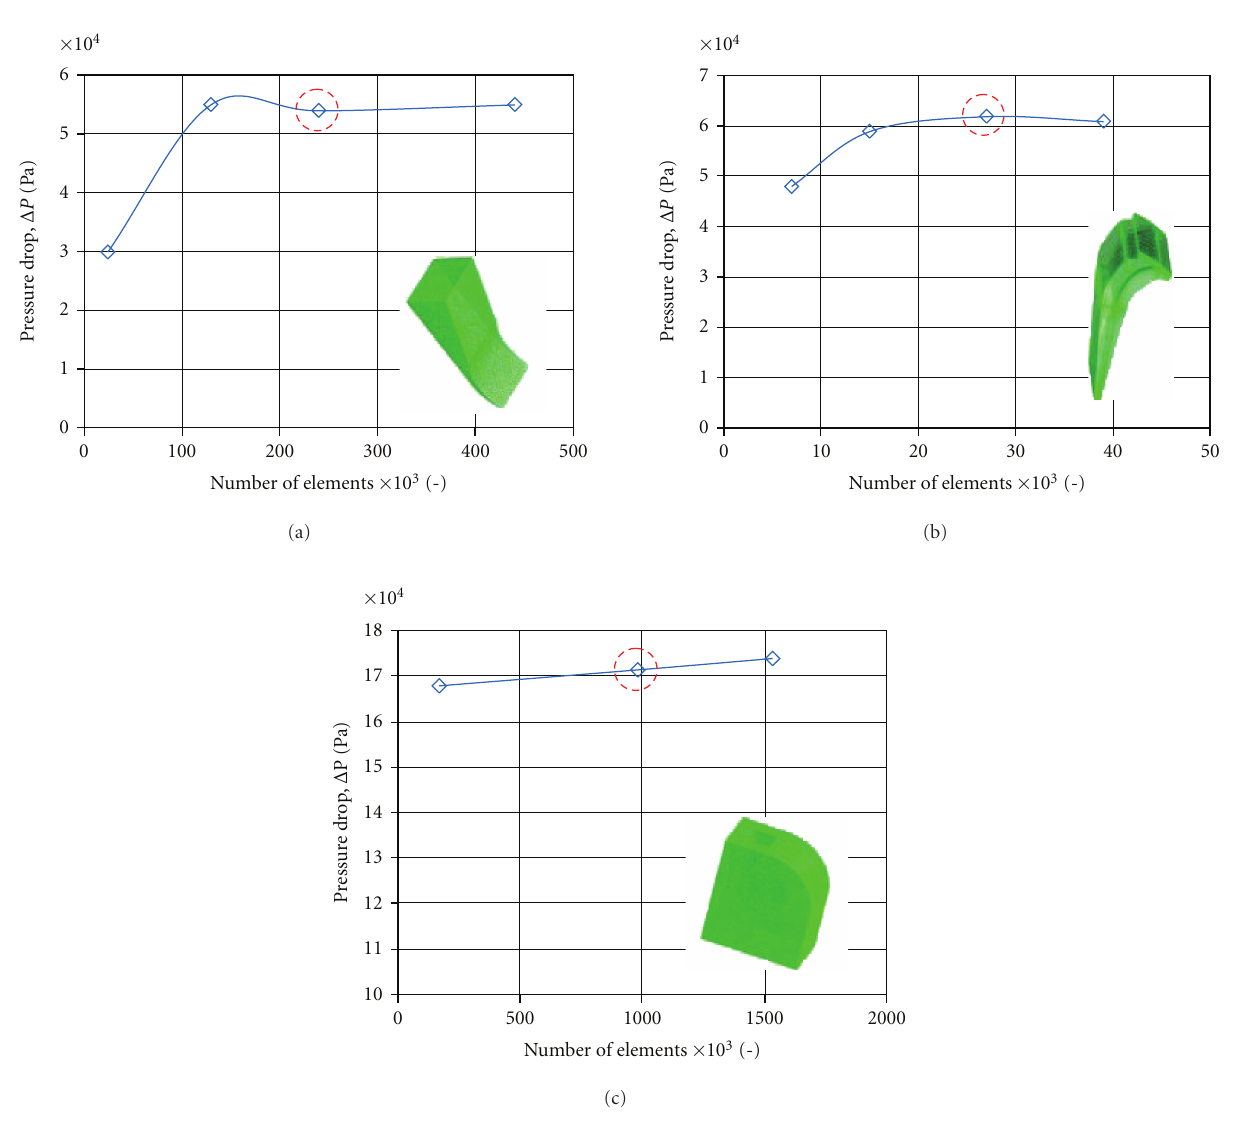
Figure 4: Influence of grid size on (a) nozzle, (b) runner blade passage, and (c) casing pressure drop.